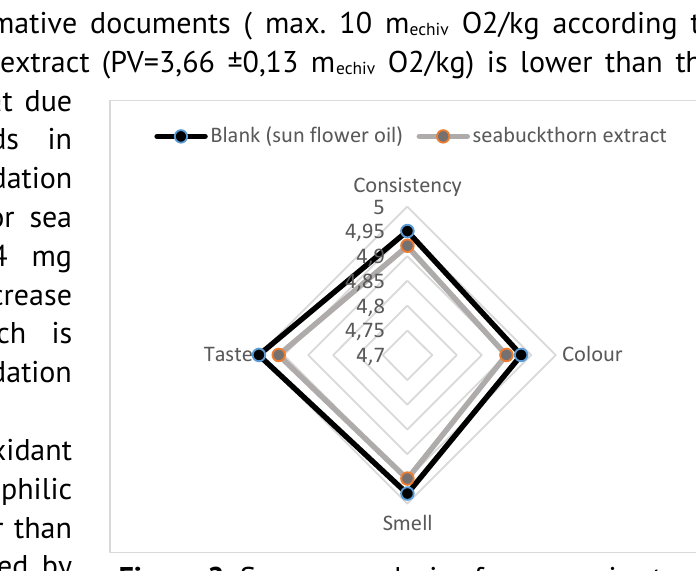
Figure 2. Sensory analysis of mayonnaise type sauce (blank - sunflower oil sample, sea buckthorn extract